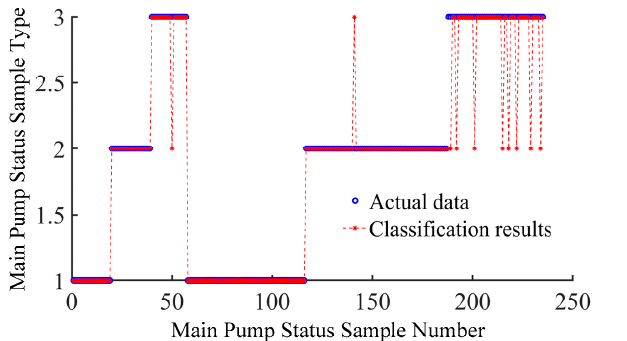
Figure 13. The result diagram of main pump health state identification based on EEMD-OQGA-SVM.